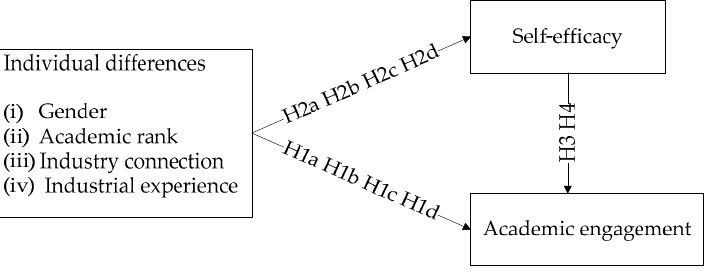
Figure 1. Theoretical framework.